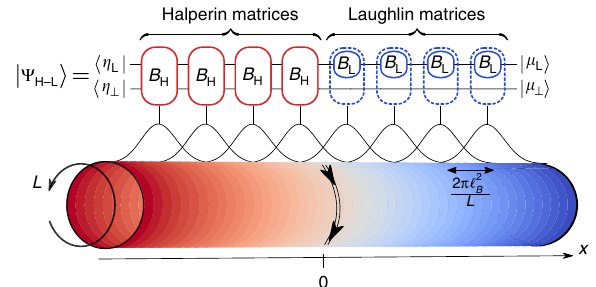
Fig. 1 Model Wavefunction for the Interface: Schematic representation of the MPS ansatz | Ψ H − L 〉 for the Halperin 221 – Laughlin 1/2 interface on a cylinder of perimeter L (i.e., we assume periodic boundary condition along the y -axis). The momentum along the compact direction labels the Landau orbitals and determines the center of their Gaussian envelope on the cylinder (schematically depicted on top of the cylinder). The Halperin iMPS I (blue) in matrices B H (red) are glued to the Laughlin iMPS matrices B L (cid:3) the Landau orbital space. Due to the embedding of one auxiliary space into the other, the quantum numbers of | μ ⊥ 〉 (see Eq. (2)) are left unchanged by the Laughlin matrices all the way to the interface. It constitutes a direct access controlling the states of the interface chiral gapless mode, graphically sketched here with a double